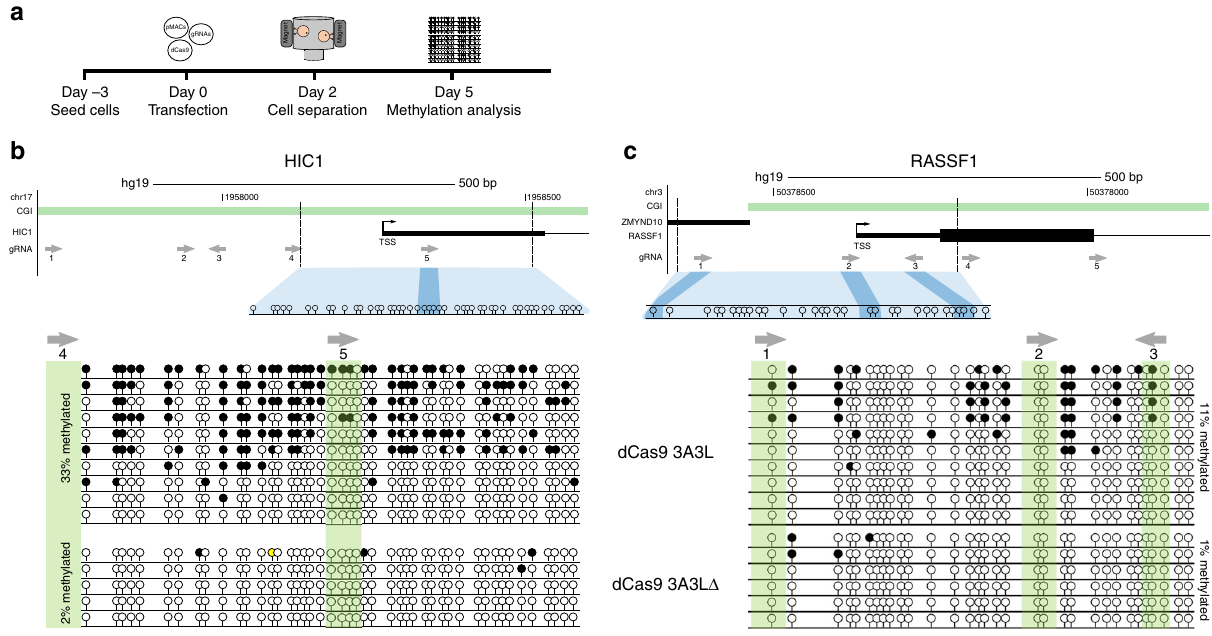
Fig. 1 dCas9 3A3L targeted hypermethylation of HIC1 and RASSF1 in primary myoepithelial cells. a Schematic of experimental design, 10 plasmids encoding gRNAs targeting HIC1 and RASSF1A promoters were transfected along with dCas9 3A3L or 3A3L Δ and the MACS (magnetic activated cell sorting) plasmid (pMACS) for magnetic selection. b A schematic depicting the gRNA location (grey arrows) in relation to the CGI (in green) and the TSS in the promoter of the HIC1 gene; the arrows point towards the PAM sequence. The dotted lines represent the region analysed by bisul fi te cloning and the locations of individual CpGs are scaled according to their genomic distribution. The dark blue shading depicts which CpGs are overlapped by gRNA #5. Lower panel shows bisul fi te cloning results from the HIC1 locus 5 days after transfecting primary myoepithelial cells from donor 1 with 10 gRNAs (targeting HIC1 and RASSF1 ) and dCas9 3A3L or 3A3L Δ as indicated. c A schematic depicting gRNA in relation to CGI and TSS in the promoter of RASSF1A . Lower panel shows bisul fi te cloning from RASSF1A 5 days after transfection of primary human myoepithelial cells with 10 gRNAs (targeting HIC1 and RASSF1 ) and dCas9 3A3L or 3A3L Δ as indicated. Arrows and green shading represent overlap between gRNAs and CpGs. Each line represents a single clone, fi lled and empty lollipops represent a single methylated or unmethylated CpG,